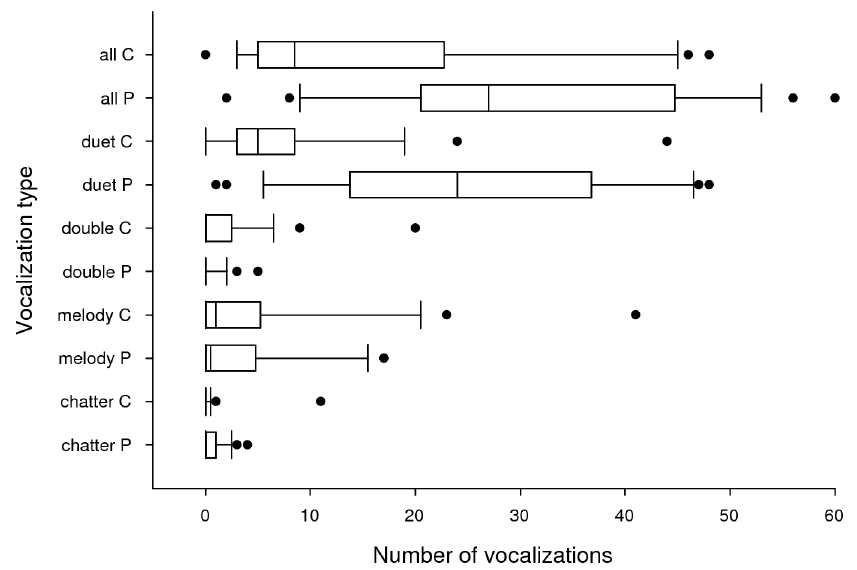
Figures 2. Boxplots of vocalizations produced by 24 groups of Plain-tailed Wrens Thryothorus euophrys in an hour after playback (P) and control (C) treatments. Boxes show the 25 th and 75 th percentiles, the center line shows the median, whiskers show the 10 th and 90 th percentiles, and points show outliers. Wrens produced more duets and total vocalizations, but not other vocalization types after playback.